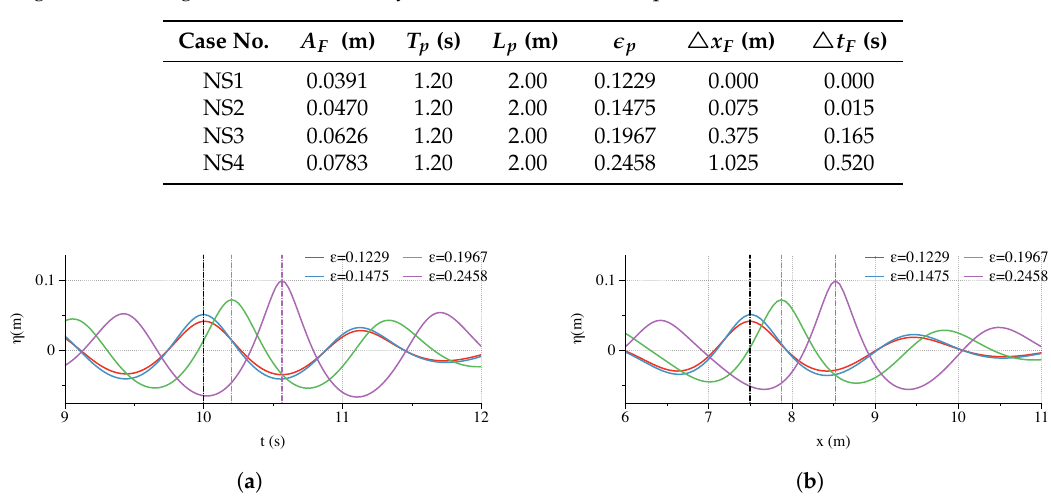
Table 3. The wave inputs and the absolute differences in the focusing points for the wave groups generated using the NewWave theory with different wave steepnesses.